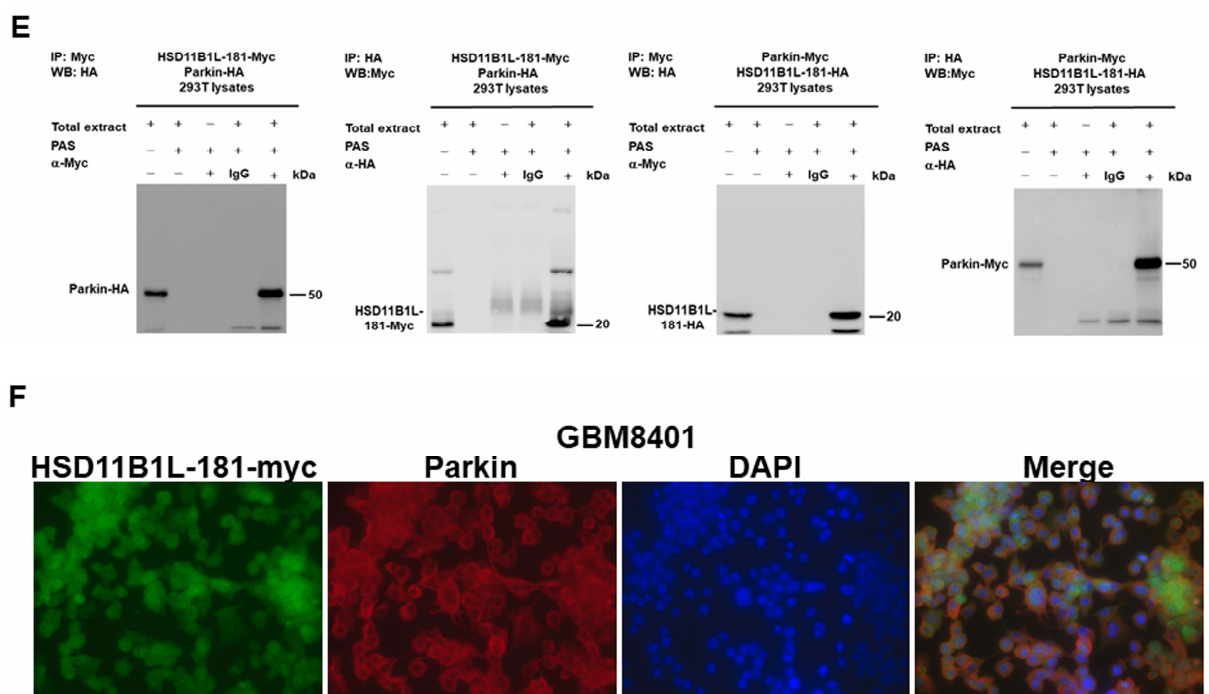
Figure 4. The specific interaction between HSD11B1L-181 and parkin (PARK2) in yeast and cells. ( A ) Schematic diagram of yeast two-hybrid screening using HSD11B1L-181 as bait. Screening of parkin prey clones from an adult brain cDNA library. Plasmids of HSD11B1L-181 with a Gal4 DNA- binding domain (BD) fusion were transformed into the AH109 strain. It was then mated with the Y187 strain containing plasmids for an adult brain cDNA library fused to the Gal4 activation domain (AD). If the interaction between the fusion proteins expressed by the two exists, the reporter gene of diploid cells can be activated and the blue clone can be formed on the SD/-Ade/-His/-Leu/-Trp/X- α-gal plate. ( B ) Positive blue diploid colonies showing parkin cDNA fragments. ( C ) Schematic rep- resentation of the sequencing of four colonies with parkin cDNA fragments (NCBI reference se- quence: NM_004562). ( D ) The interaction of HSD11B1L-181 with the coding region of the full-length parkin cDNA was confirmed by yeast two-hybrid analysis. The interaction of BD-p53 and AD-T in diploid cells served as a positive control group. ( E ) Interaction of HSD11B1L-181 with parkin was